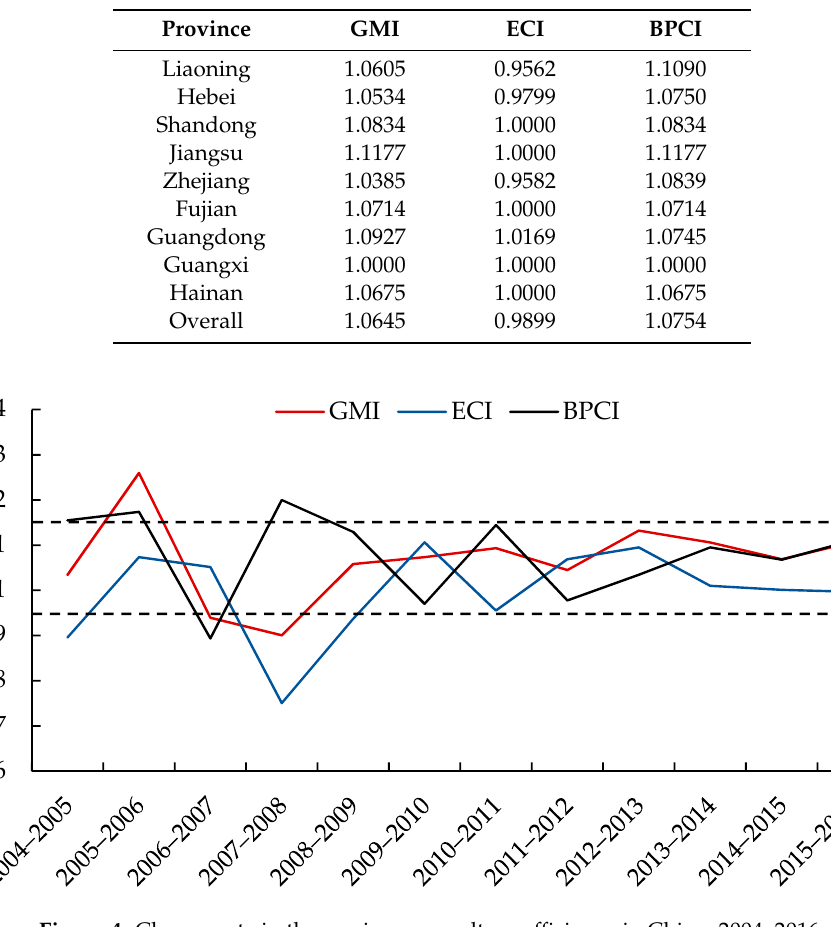
Figure 4. Change rate in the marine aquaculture efficiency in China, 2004–2016.